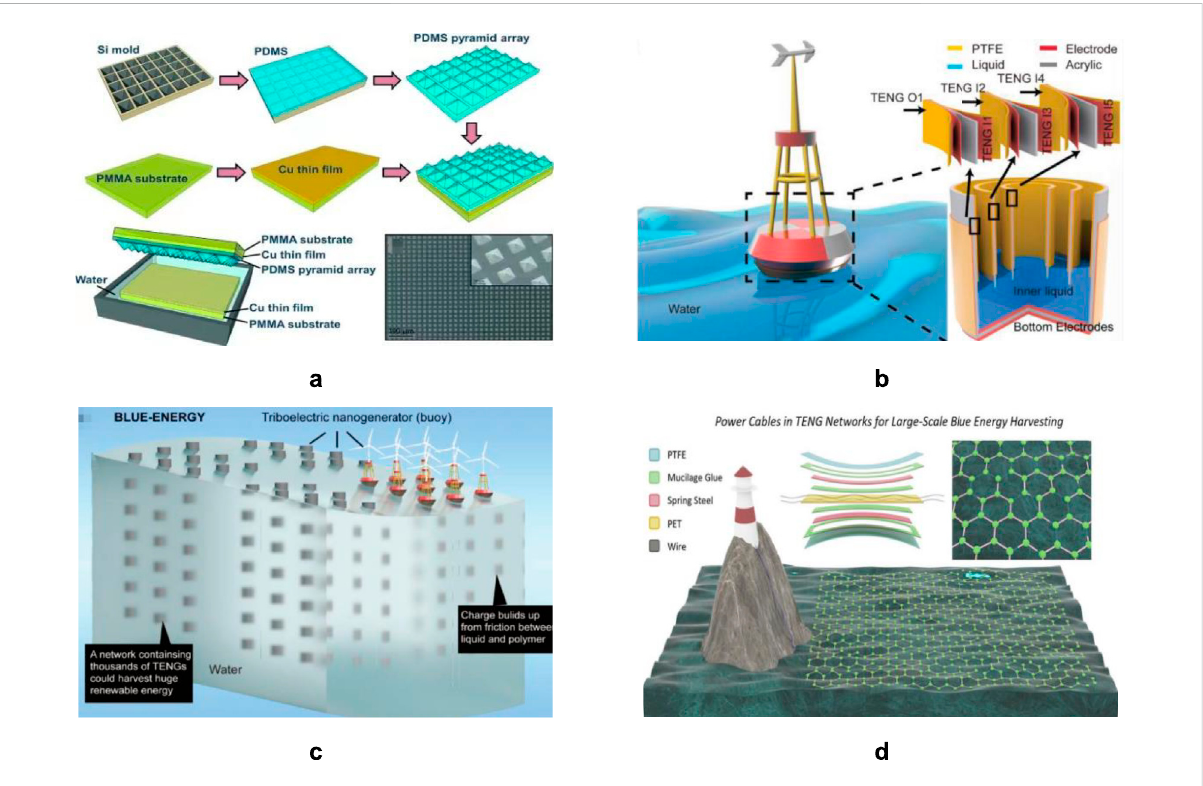
FIGURE 10 Liquid-solid contact TENG (A) First liquid-solid TENG structure (Lin et al., 2013). (B) Floating liquid-solid TENG power generation structure. (C) Application scenario of buoyed liquid-solid TENG (Li et al., 2018). (D) TENG network with a cellular topology connected by power cables (Liu et al.,